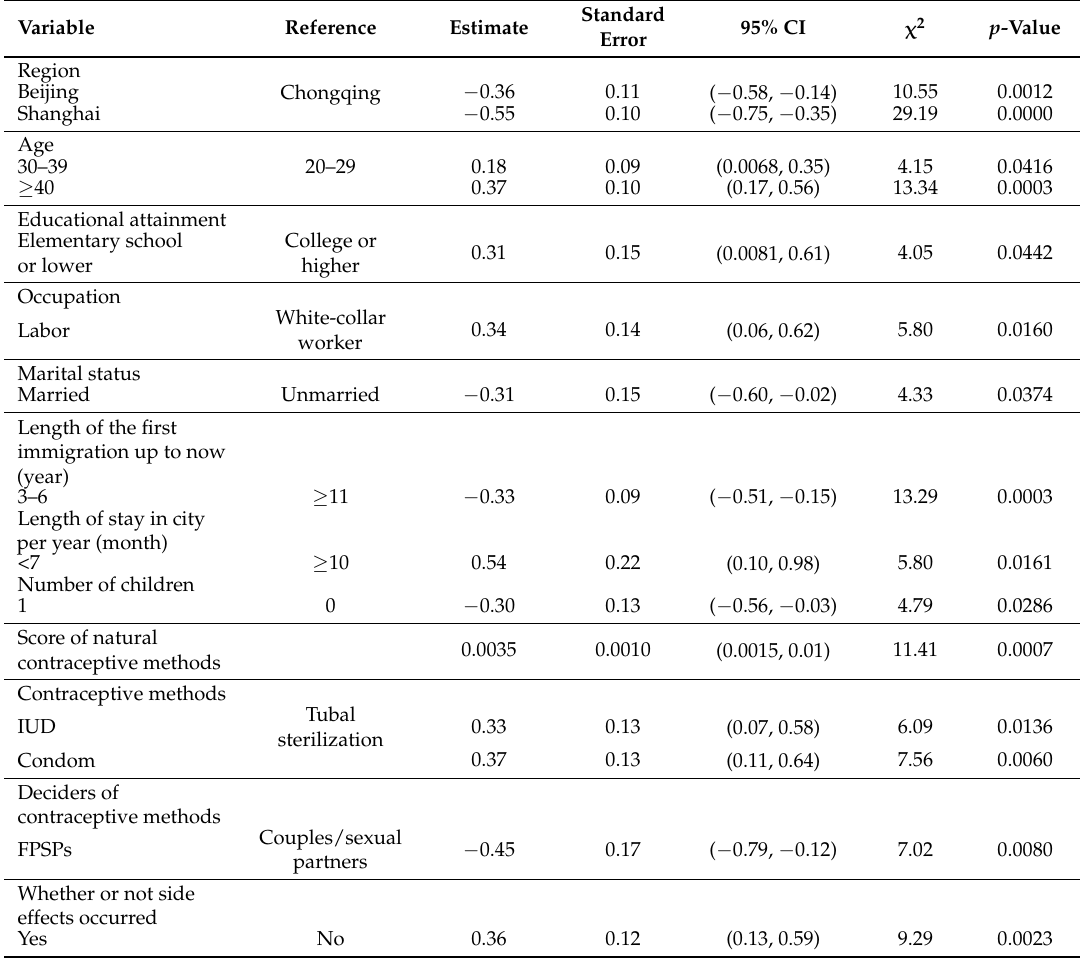
Table 3. ZINB analysis of informed choice correlated with induced abortions among immigrant women.